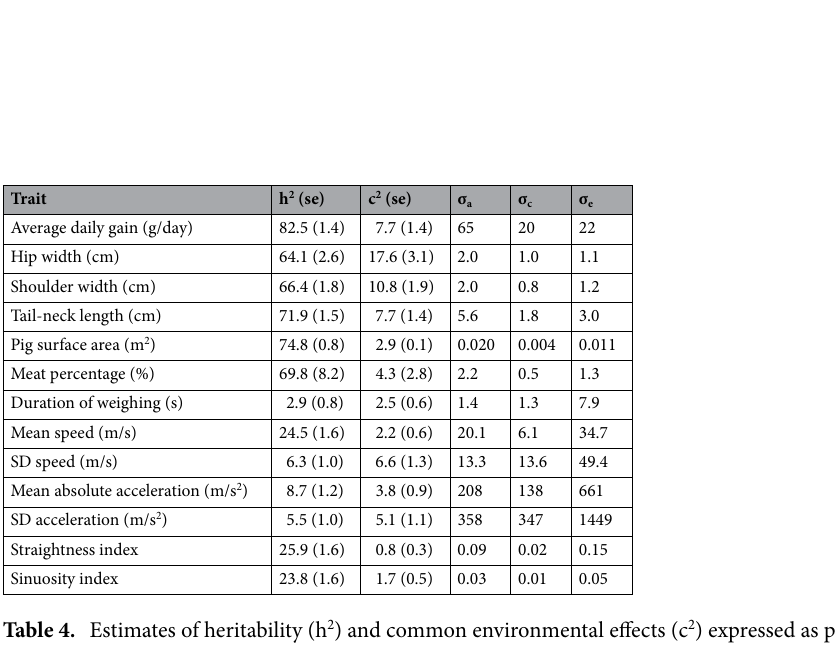
Table 4. Estimates of heritability (h 2 ) and common environmental effects (c 2 ) expressed as percentage, as well as additive genetic standard deviation (σ a ), random permanent environmental standard deviation (σ c ) and residual standard deviation (σ e ). Activity scores shown are based on estimates from the tail base; All other estimates are shown in Additional File 7 Table S1 Additional File 6 Fig.